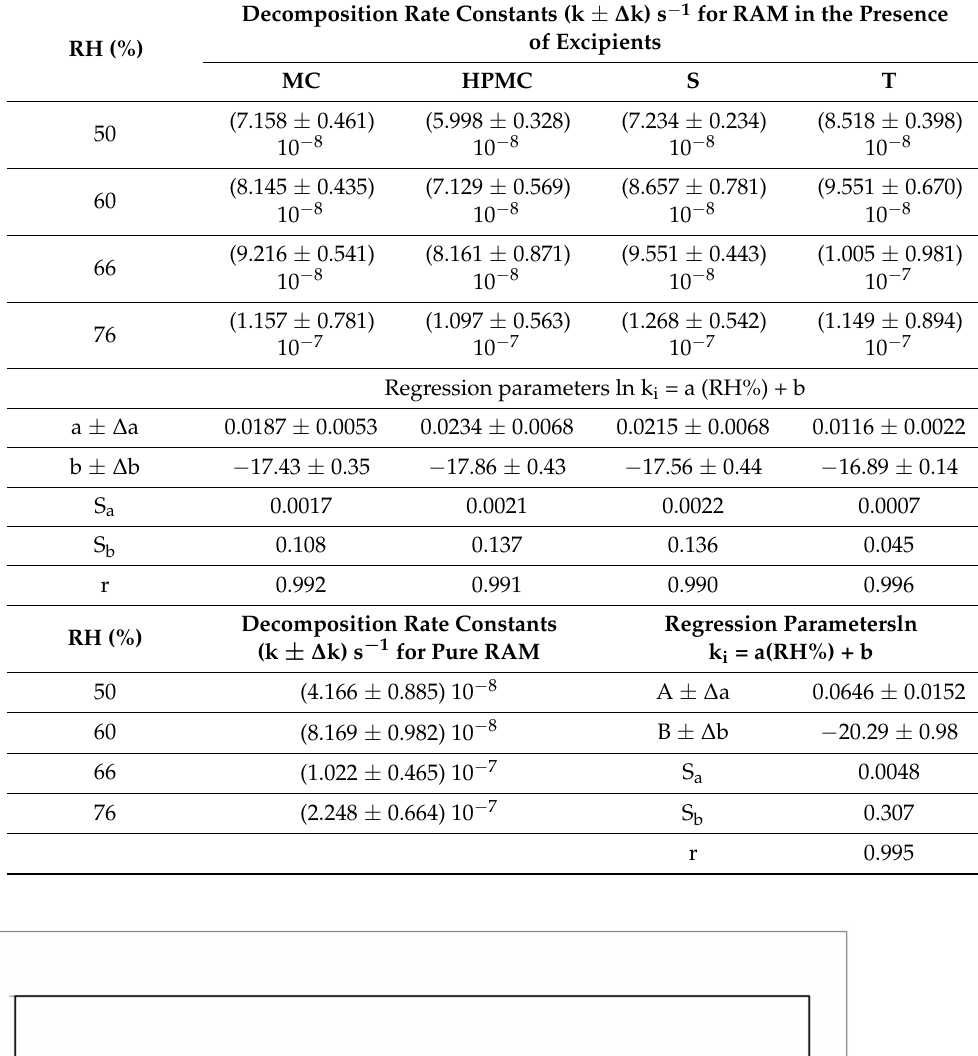
Table 4. The influence of RH on the stability of RAM in pure form and in the presence of the